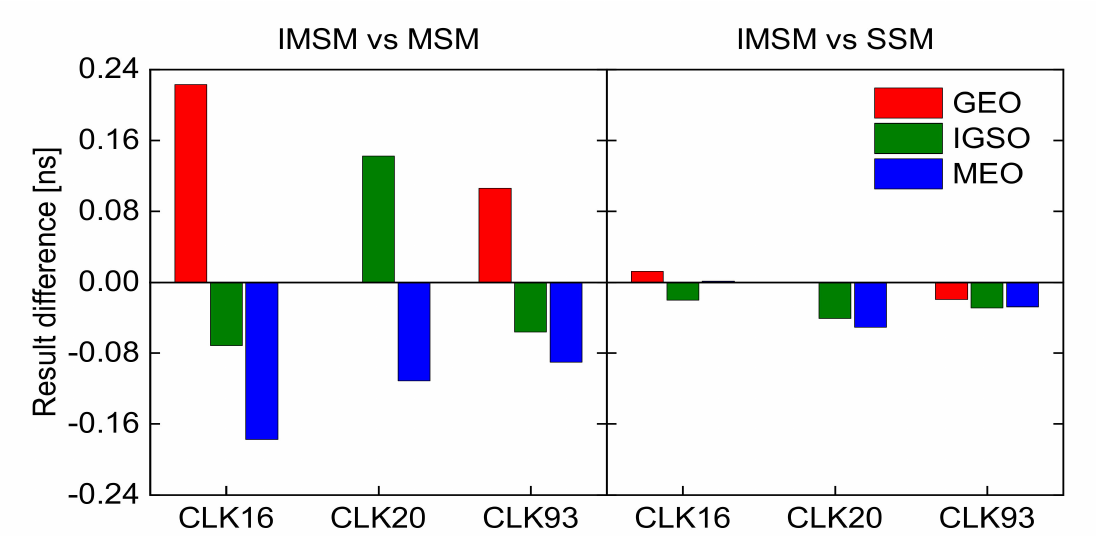
Figure 8. Averaged result di ff erences of the improved multi-satellite method (IMSM) with respect to the multi-satellite method (MSM) and the single-satellite method (SSM). Note that the geosynchronous earth orbit (GEO) clock products are not provided in CLK20, so they are not shown in the